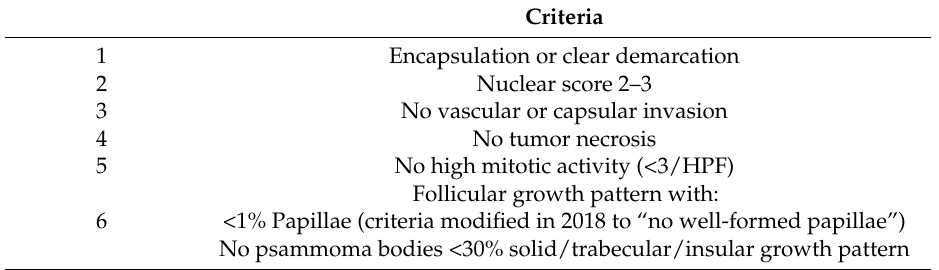
Table 1. Noninvasive follicular thyroid neoplasm with papillary-like nuclear features (NIFTP)